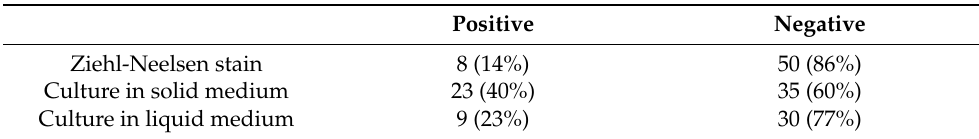
Table 4. Diagnostic yield of microbiology tests in pleural biopsy specimens from patients with tuberculous pleural effusion.